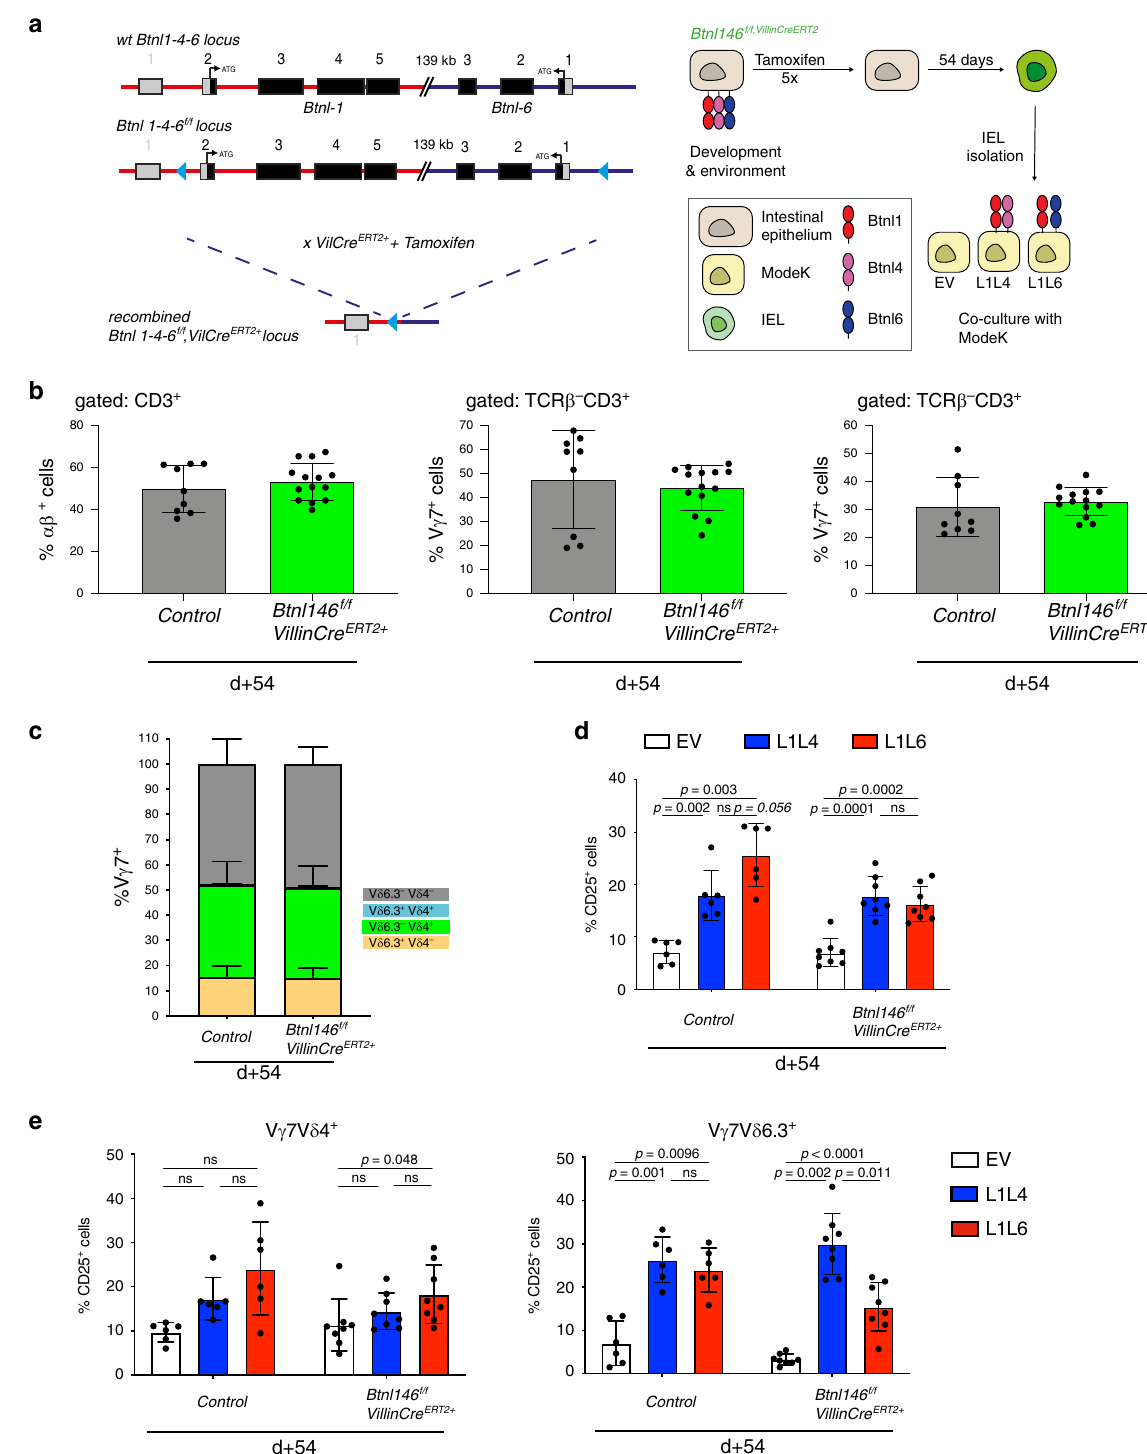
Fig. 6 Response and maintenance by Btnl1 and Btnl6 . a Left: Targeting strategy to generate animals harbouring a fl oxed Btnl146 locus, which can be excised after tamoxifen administration. Right: Experimental design for IEL analysis ( c , d ) and co-culture experiment ( e ) following Btnl146 locus depletion. During development Btnl molecules are expressed on the IEC and only after tamoxifen depletion Btnl expression is lost. Following loss of Btnl expression, IELs are harvested and subjected to co-cultures with MODE-K cells expressing speci fi c Btnl combination. b Quanti fi cation of αβ (left), V γ 7 + (middle) and V γ 1 + (right) T cells following Btnl146 locus depletion. n ctrl : 9, n Btnl146VcreERT2 + : 14. Data are mean ± SD. c Quanti fi cation V δ chain usage in V γ 7 + cells in animals of indicated genotypes under indicated conditions. n ctrl : 6, n Btnl146VcreERT2 + : 8. Data are mean ± SD. d Co-culture of MODE-K cells transduced with EV, L1L4 or L16 with IEL from control, or Btnl146 f/f ;Villin CreERT2 + animals. Controls are pooled: Btnl146 f/f ,Villin CreERT2 + that did not receive tamoxifen and Btnl146 f/f ,Villin CreERT2 – animals that did receive Tamoxifen. Data are mean ± SD ( n ctrl : 6, n Btnl146VcreERT2 + : 8). Statistical analysis two-way ANOVA & Tukey ’ s multiple comparison post test. e IEL response in co-cultures of MODE-K cells transduced with EV, L1L4 or L1L6 with IEL from control or Btnl146 f/f ; Villin CreERT2 + animals that did receive tamoxifen in V γ 7V δ 4 + (left graph) and V γ 7V δ 6.3 + (right graph) cells. n ctrl : 6, n Btnl146VcreERT2 + :